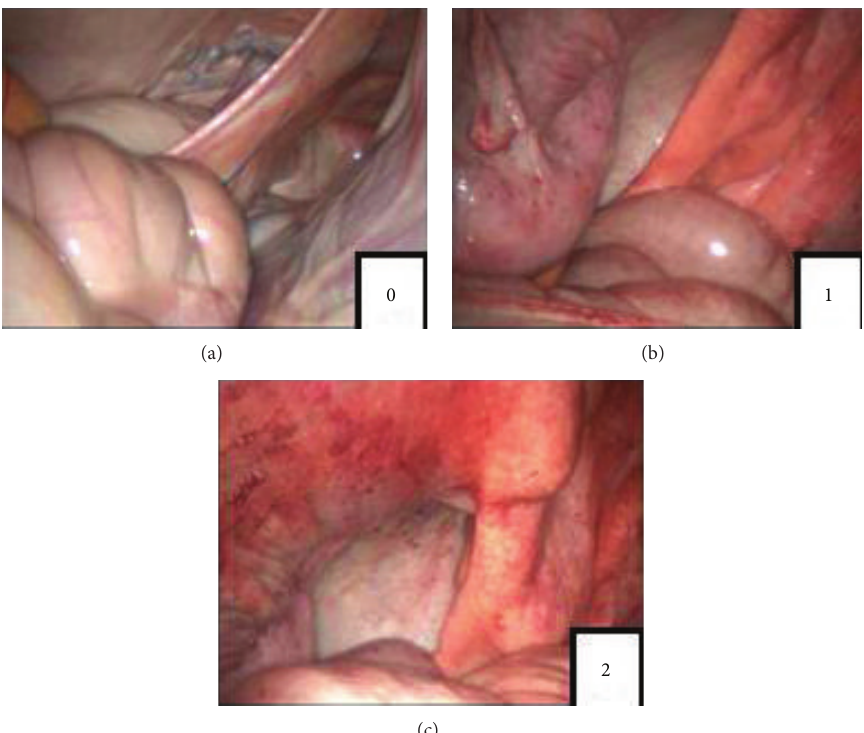
Figure 3: Score system of diffuse peritoneal reactivity, being 0 (no diffuse reactivity), 1 (mild diffuse reactivity), and 2 (moderate diffuse reactivity).